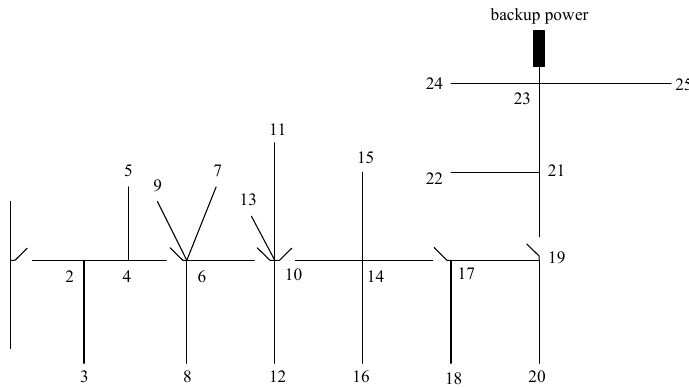
Figure 11. Example 1: optimal switch-distribution map (with contact, five switches).